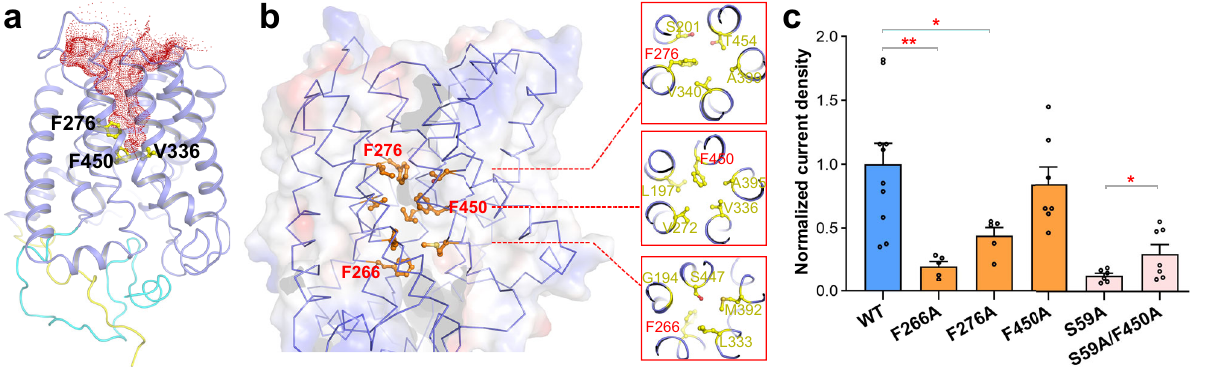
Fig. 3 At SLAC1 S59A structure is in a nonconductive, inactivated state. a Pore depiction of the At SLAC1 S59A structure. The anion conduction pore, calculated by HOLE2 40 , is shown as red mesh. The structure is shown in a cartoon model, with the transmembrane domain colored slate blue, the N-terminus colored cyan, and the C-terminus colored yellow, respectively. The upper half of the channel is open to the periplasmic side of the cell, whereas the lower half is completely sealed. b Three ring-shaped layers of hydrophobic residues located along the anion path are shown in sticks. Each layer contains a phenylalanine residue, F276, F450 and F266. c Normalized inward current densities measured at − 100 mV for the phenylalanine residue mutants compared to the WT At SLAC1 characterized in the HEK293T cells. Independent experiments were repeated for each construct (WT, n = 10; F266A, n = 5; F276A, n = 5; F450A, n = 7; S59A, n = 6; S59A/F450A, n = 7). Signi fi cances were determined using one-way ANOVA with Dunnett ’ s multiple comparisons test for the single phenylalanine mutants, and unpaired t -test between the S59A and S59A/F450A mutants. * P = 0.0354 for the F276A mutant; ** P = 0.0296 for the S59A/F450A mutant; ** P = 0.0023 for the F266A mutant. Data are represented as mean ±